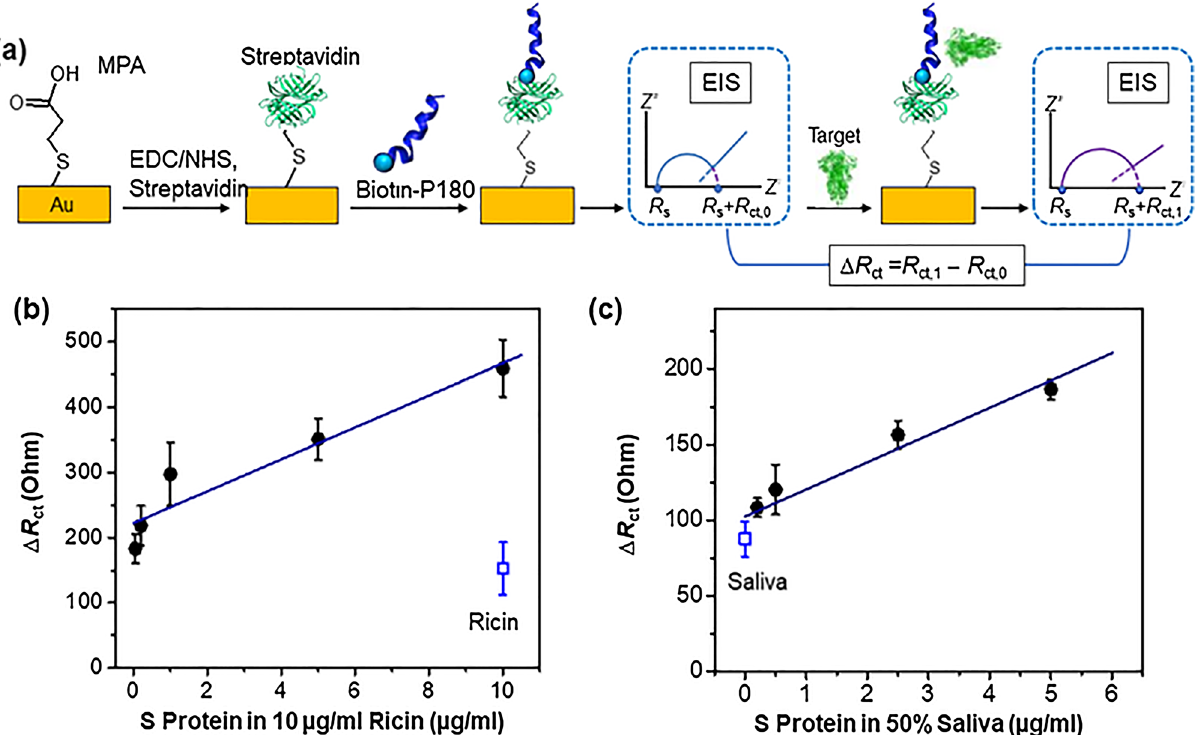
Figure 4. Electrochemical sensing of s protein with peptide binder. ( a ) Schematic of the immobilization of the P180 peptide on gold electrodes for EIS measurements to quantify binding with SARS COV2 S protein based on alteration in charge transfer resistance (DR ct ). ( b ) Signal (DR ct ) as a function of S protein levels in Ricin background at 10 µg/mL. ( c ) Signal (DR ct ) as a function of S protein levels in 50%